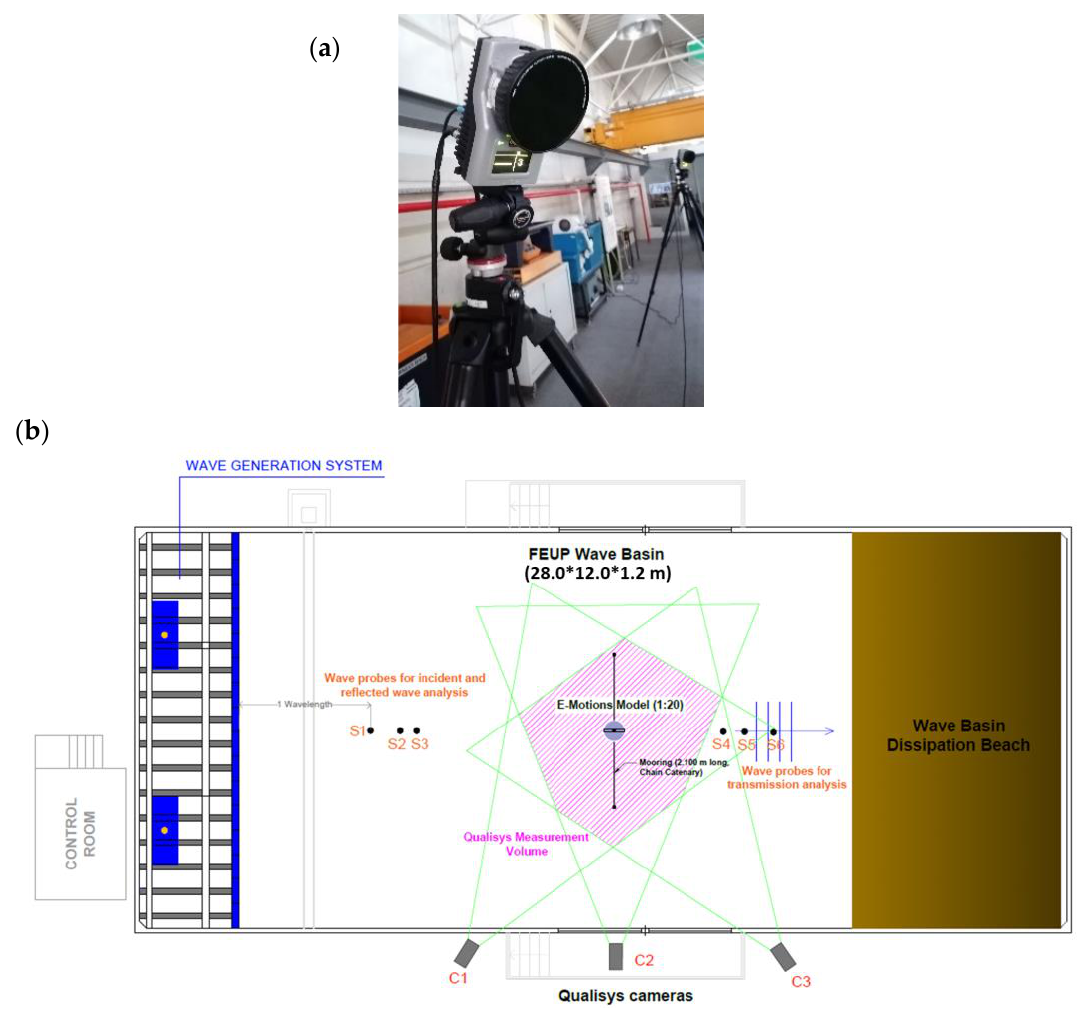
Figure 5. Close-up view of a Qualisys camera ( a ) and experimental setup, top view schematic ( b ). The minimum wavelength distance of the first trio of probes was adjusted, for each test, in accordance with the varying wave period.